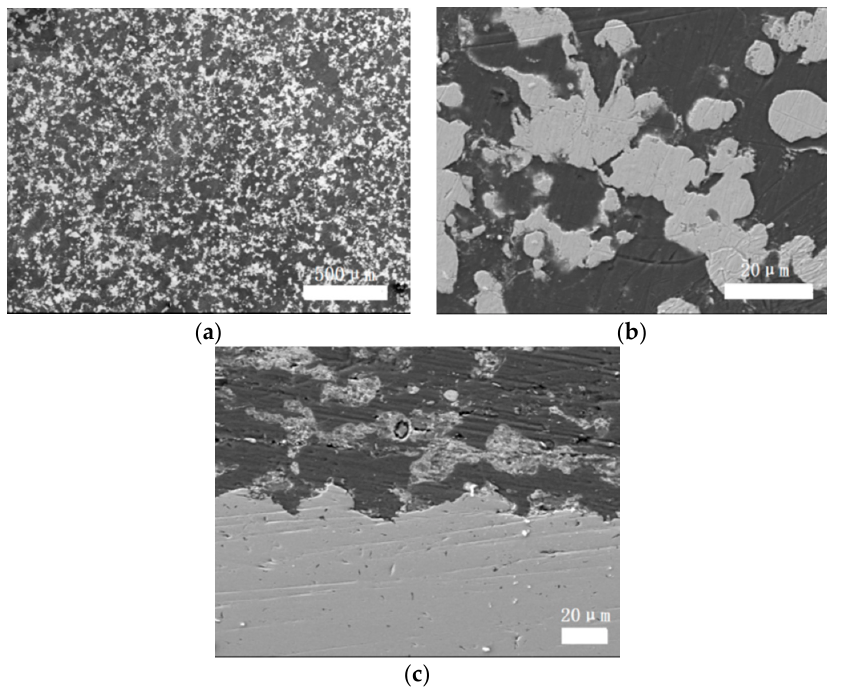
Figure 1. ( a ) Enlarged 50× view of the coating, ( b ) enlarged 1000× view of the coating, bright region is zinc and dark region is aluminum, ( c ) enlarged 500× view of the interface, upper part is a composite coating and the lower part is the base.